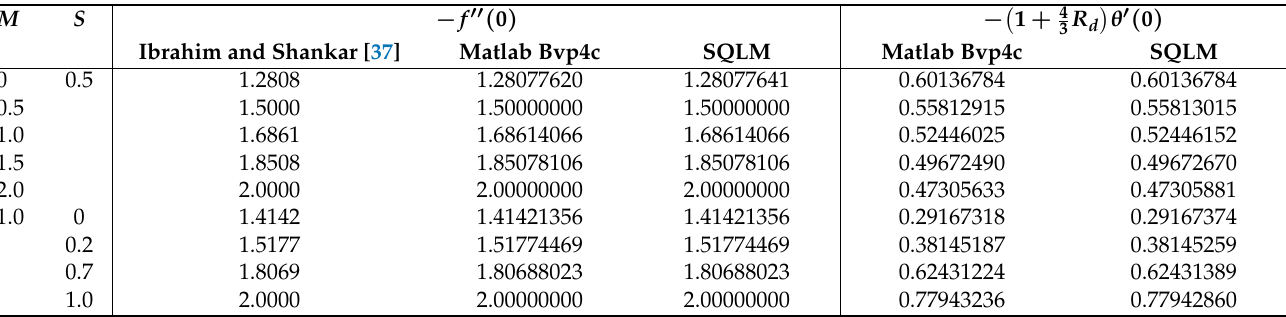
Table 2. The values of − f (cid:48)(cid:48) ( 0 ) and − bvp4c for selected values of M and S when A = 0 = β , M = 1.0 = γ , Nt = Nb = Ec = R d = 0.1, Sc = 0.6 and Pr = 0.71.